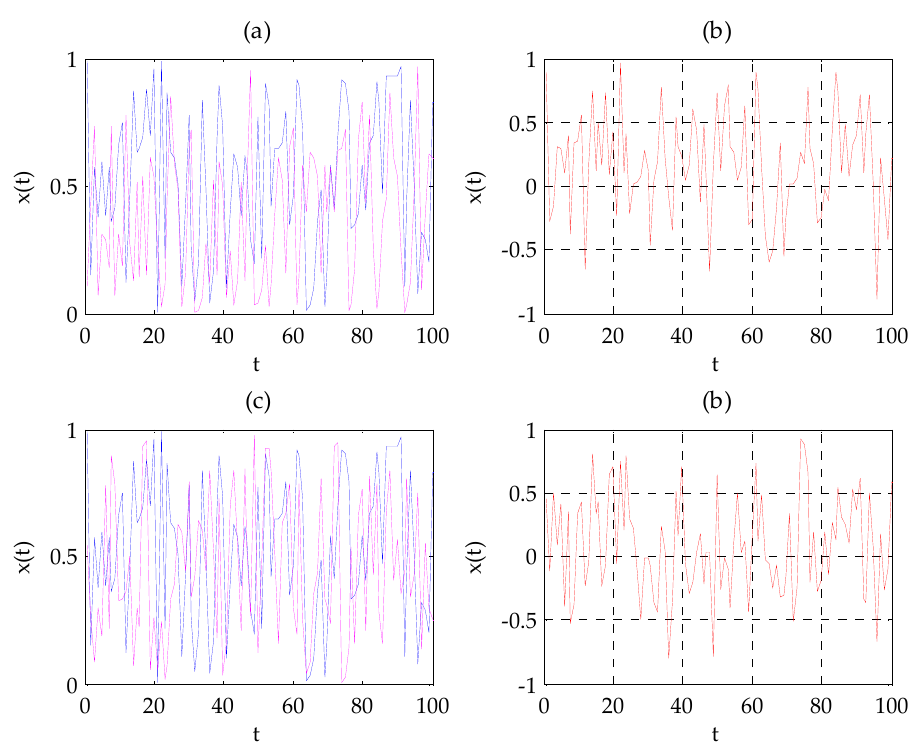
Figure 11. Schematic diagram of the sensitivity of system (3) to the initial values and system parameters; ( a ) perturbation trajectory diagram of parameter a ; ( b ) perturbation difference diagram of parameter a ; ( c ) perturbation trajectory diagram of the initial value; ( d ) perturbation difference diagram of the initial value.